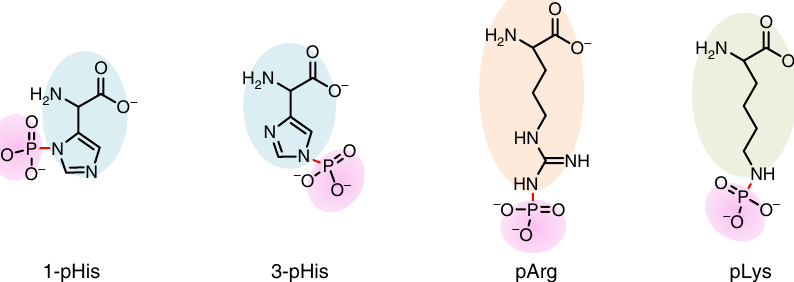
Fig. 1 Structure of three types of N-phosphorylation. Phosphorylation occurs at the side chain of peptides histidine, arginine, and lysine, generating P – N